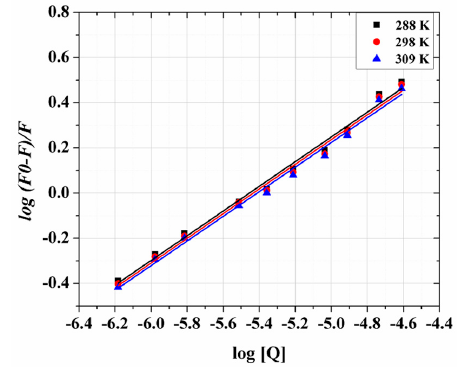
Figure 5. Plots of log [( F 0 − F )/ F ] vs. log [ Q ] for the compound 3- BSA interaction at different temperatures.